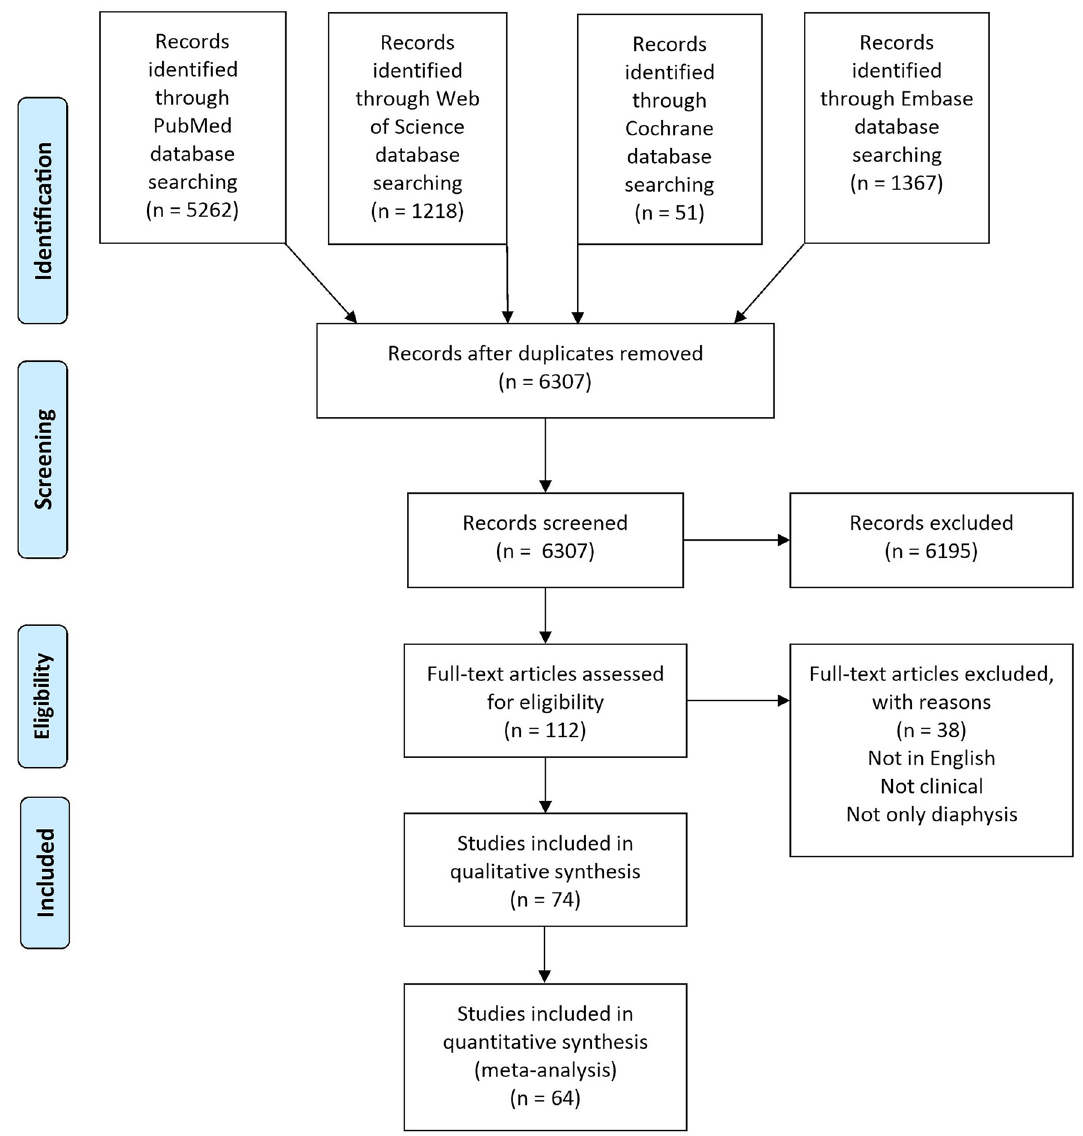
Figure 1. PRISMA (Preferred Reporting Items for Systematic Meta-Analyses) flowchart of the study selection